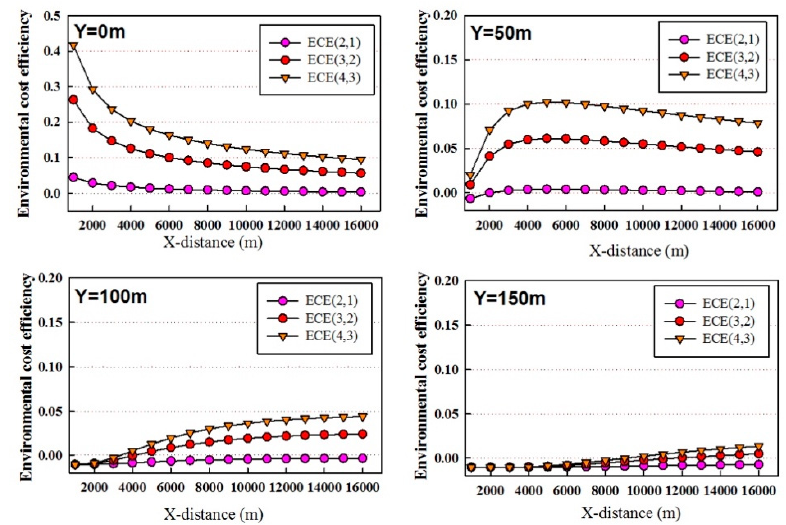
Figure 4. The eco-efficiency analysis for the WWTP case that was supposed to be built on the bank of a bigger river (Songhua river).